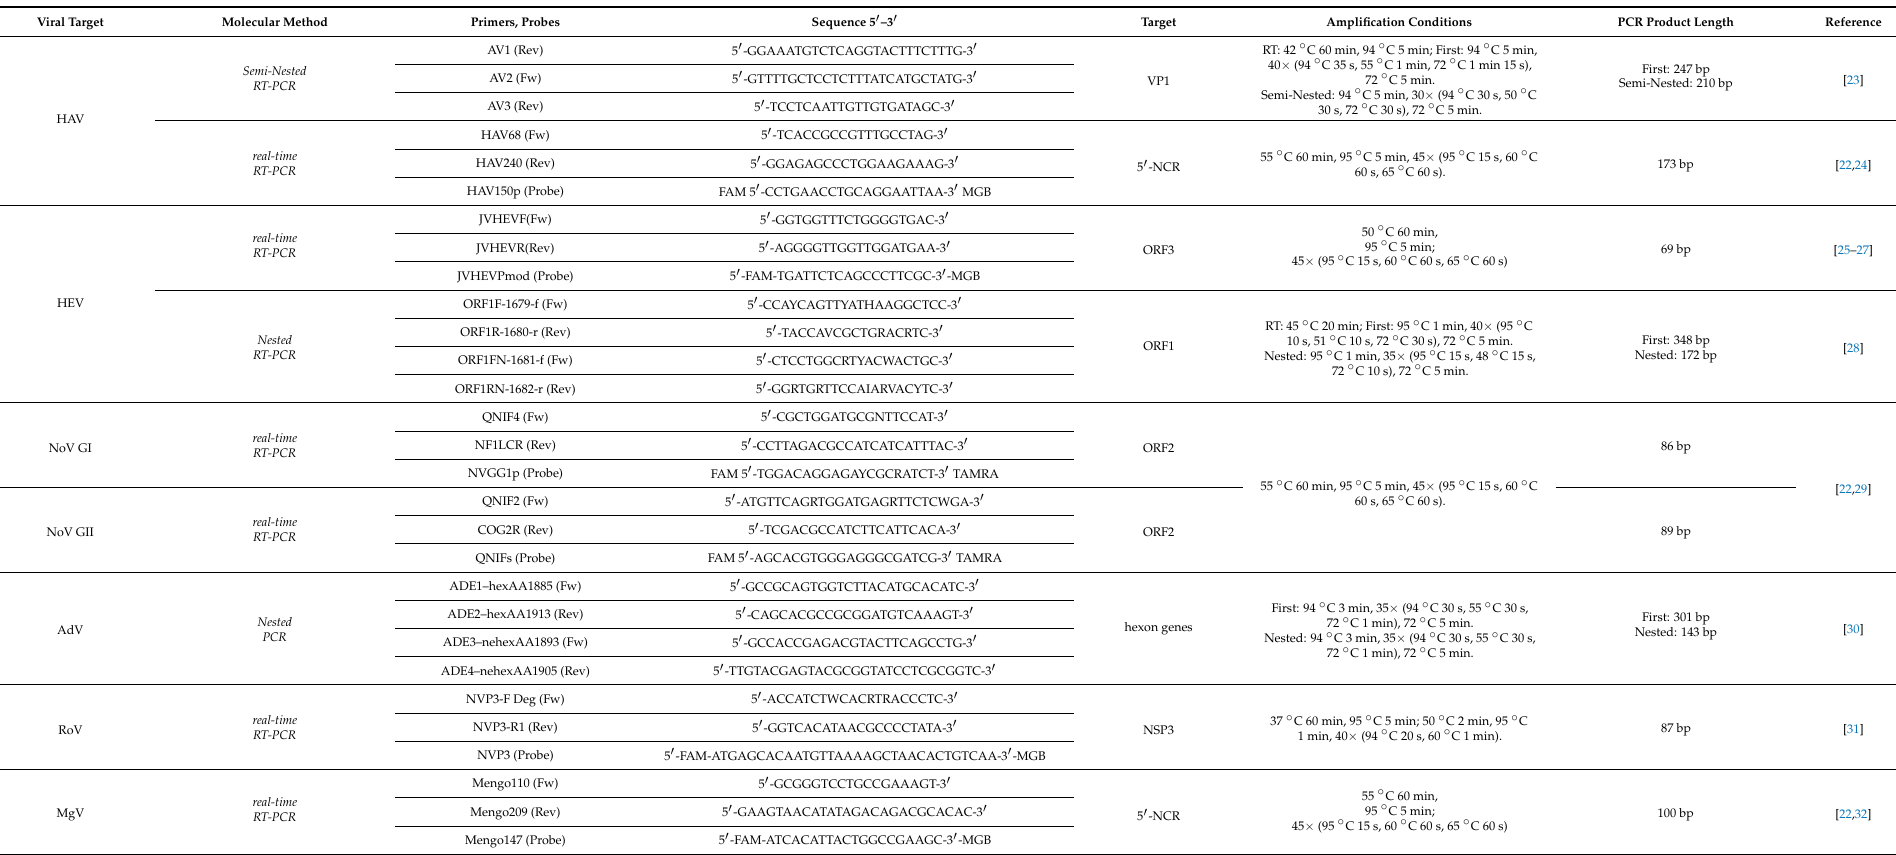
Table 1. Molecular assays used in this study to detect and genotype enteric viruses in shellfish. The sets of primers and probe, targeted regions and cycling conditions are specified for each viral target and molecular